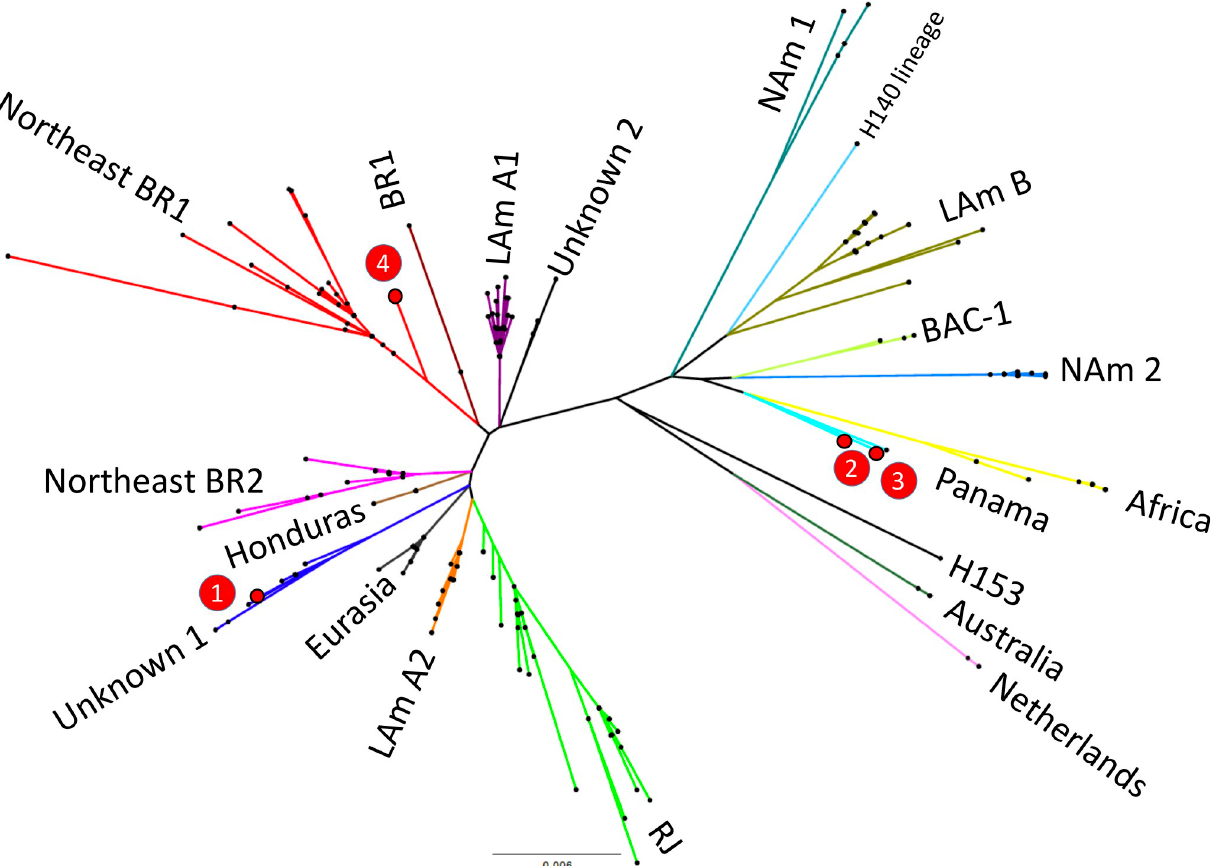
Fig 3. Unrooted maximum likelihood tree of 255 Histoplasma sp. taxa. Branch lengths are proportional to the number of nucleotide substitutions accumulated by every lineage (see the scale below the tree). The four genotyped strains (1 to 4) are highlighted in red and the main genetic clusters of the genus Histoplasma are shown. Nam2: North American class 2, Lam A2, LAmA1, Lam B: Latin American group A and group B, BAC: bat-associated cluster (BAC), BR: